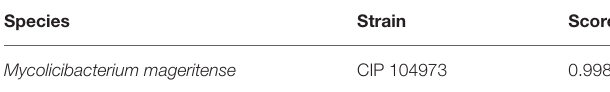
TABLE 2 | MLST score of the isolate. Species Strain